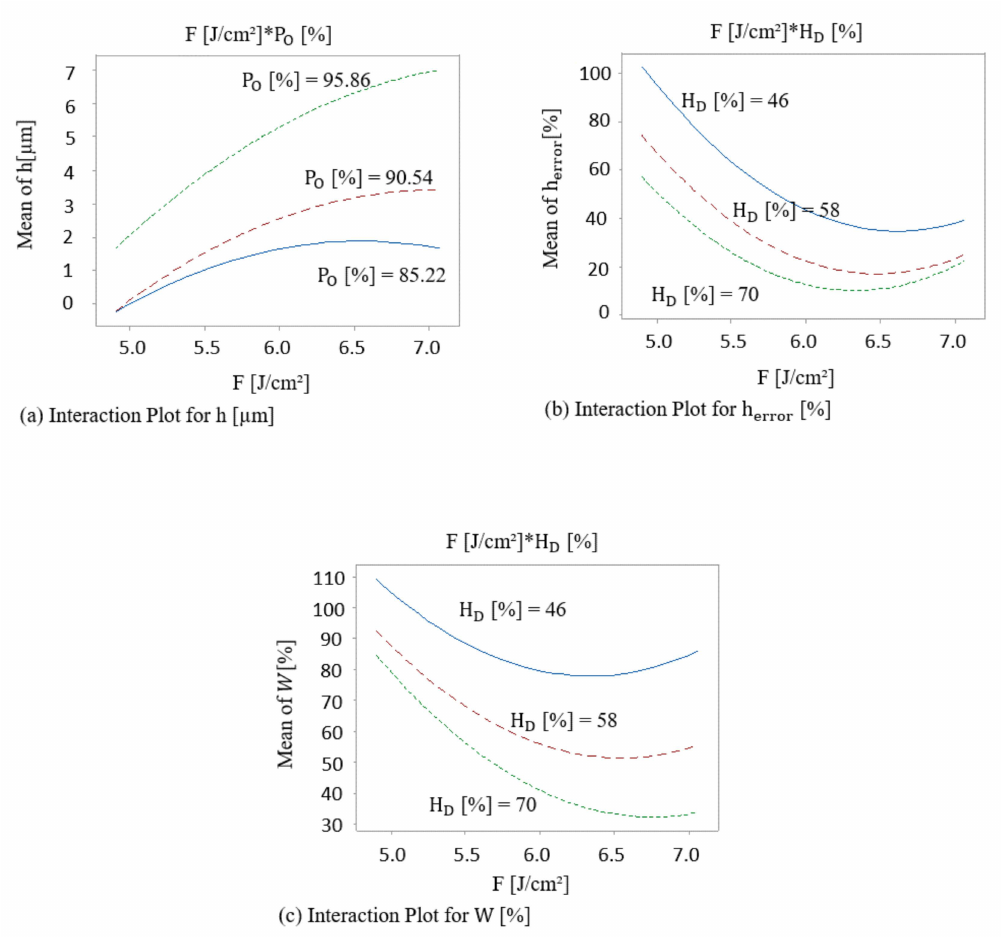
Figure 7. Interaction plots of F (J / cm 2 ) · P O (%) for the ( a ) structures height, and of F (J / cm 2 ) · H D (%) for ( b ) structure height error, and ( c ) surface